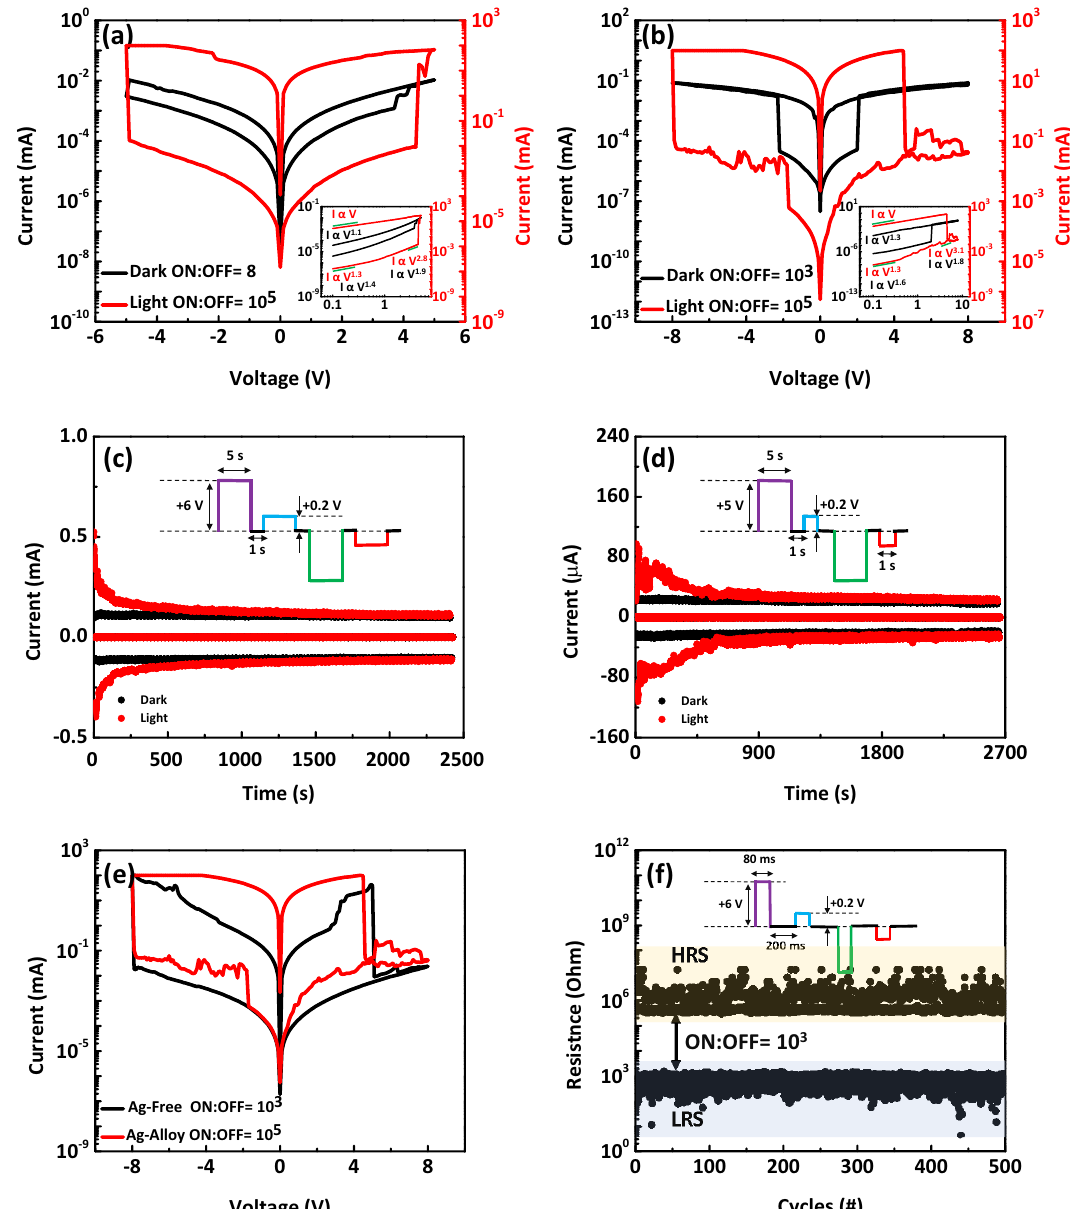
Figure 4. ( a, b ) I–V curves of sweeps in dark (black plot) and light (red plot) states for memristor devices based on GFC ( a ) and GFA ( b ) composites. An excellent enhancement of the memristive performance of devices was observed under light illumination. Inset: Log–log plot of sweeps which show an Ohmic I–V behavior in the low bias region of both set and reset states. In the dark state (black plots), by increasing the bias, the SCLC transport remains the dominant mechanism of graphene-include devices. However, due to the TCLC transport, the slope of the curves has increased under light illumination (red plots). ( c, d ) Symmetric switching performance test of on GFC ( c ) and GFA ( d ) composites for one hundred cycles in dark (black plot) and light (red plot) states. The inset shows the shape of the applied voltage pulse, which consists of four segments. ( e ) The electrical I–V characteristic of active metal-free device (black plot) and GFA-based optical memristor (red plot) under light illumination with 20 mW cm −2 . ( f ) Time-dependent measurement of GFA-based optical memristor switch featuring stable endurance over 600 cycles in dark state. The resistance of the high resistance state (HRS) and low resistance state (LRS) is determined by measuring the current at a small bias of 0.2